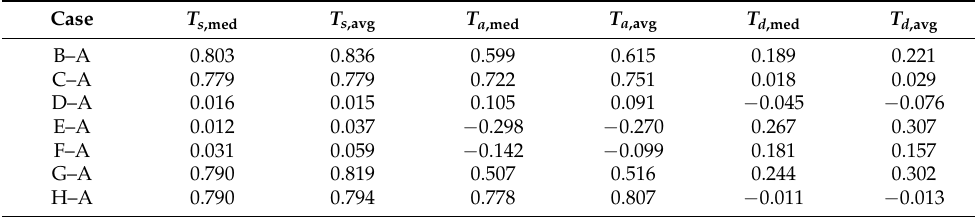
Table 10. Difference of T s , T a and T d from case A.